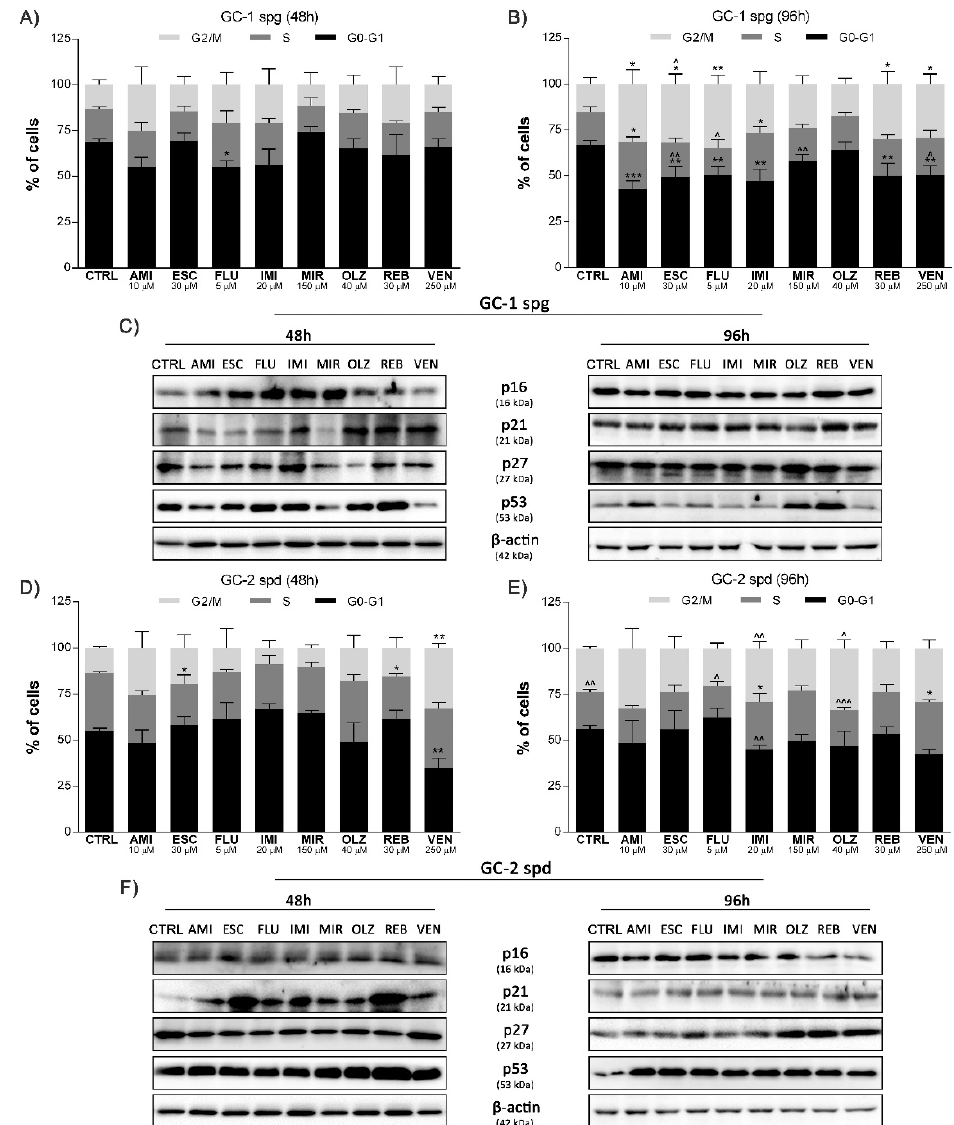
Figure 2. Antidepressant-induced cell cycle profile regulation through related genes activation. GC-1 spg and GC-2 spd cells were treated with antidepressants for 48 and 96 h, the cell cycle profile ( A , B , D , E ) was determined and the level of p16, p21, p27, p53 proteins was controlled by Western blot technique. Representative blots are shown ( C , F ). Statistical differences were determined using one-way analysis of variance (ANOVA) with Dunnett’s post-hoc test; p values < 0.05 were considered statistically significant. Asterisks (*) indicate the comparison between control and antidepressants-treated cells, whereas carets (^) indicate the comparison between the same drugs in different periods (48 vs. 96). Bars indicate mean ± SD, n = 3, ***/^^^ p < 0.001, **/^^ p < 0.01, */^ p < 0.05, no indication–no statistical significance.